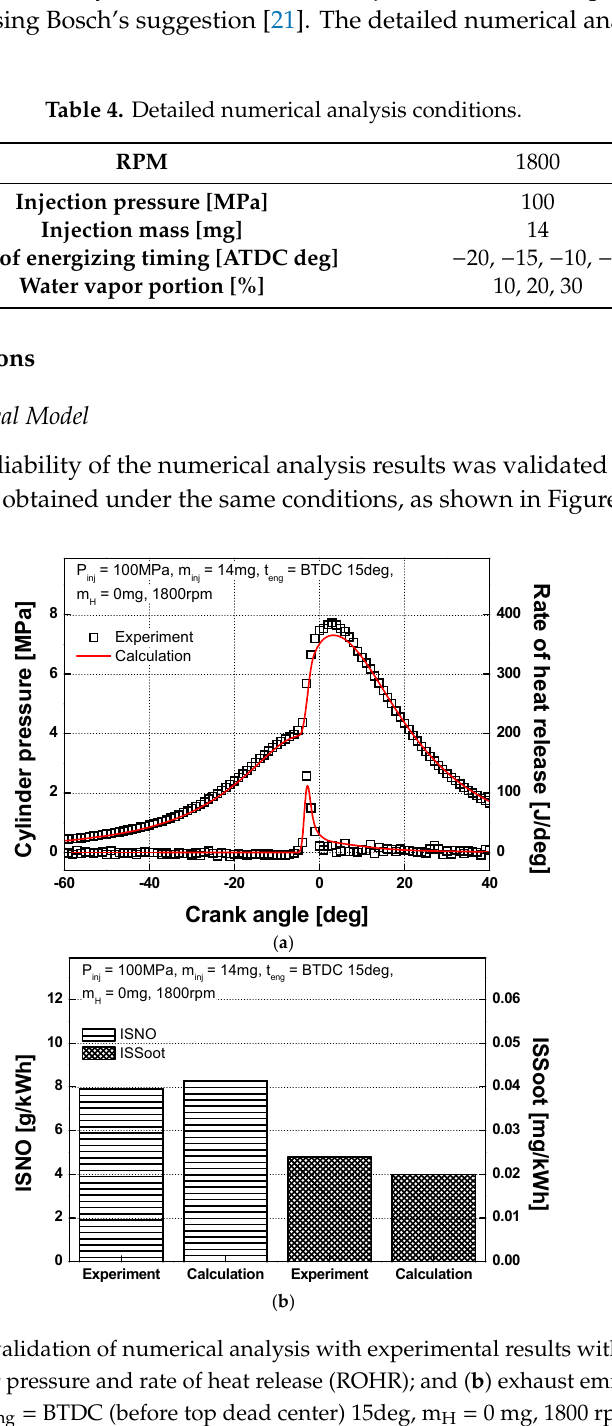
Table 4. Detailed numerical analysis conditions.